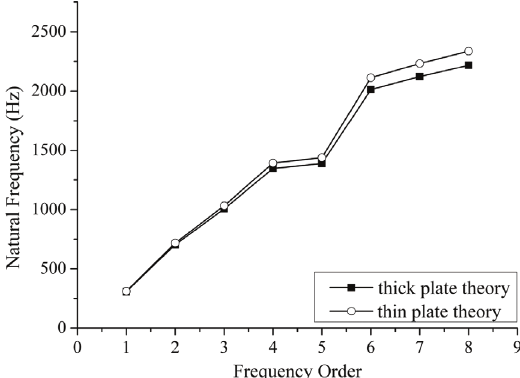
Fig. 7. Comparisons of natural frequency.